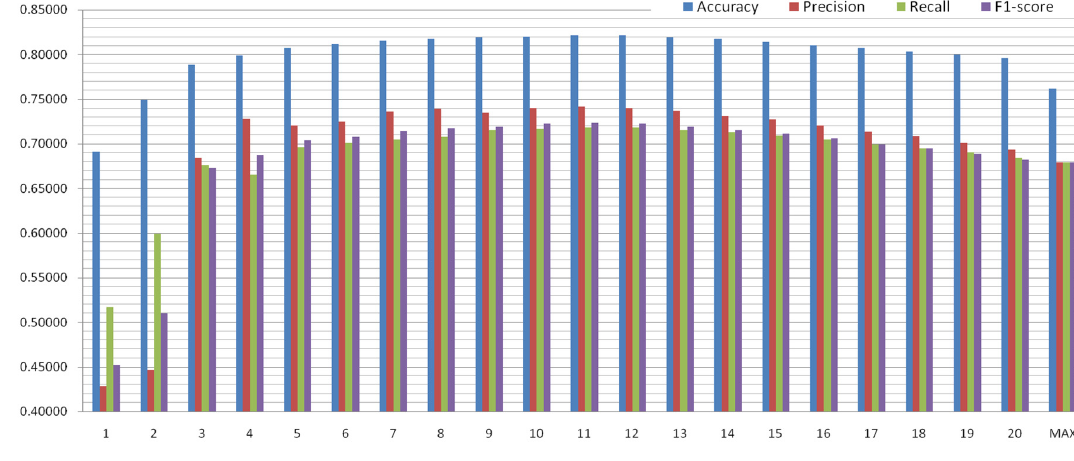
Figure 5. Evaluation indicators of the decision tree.